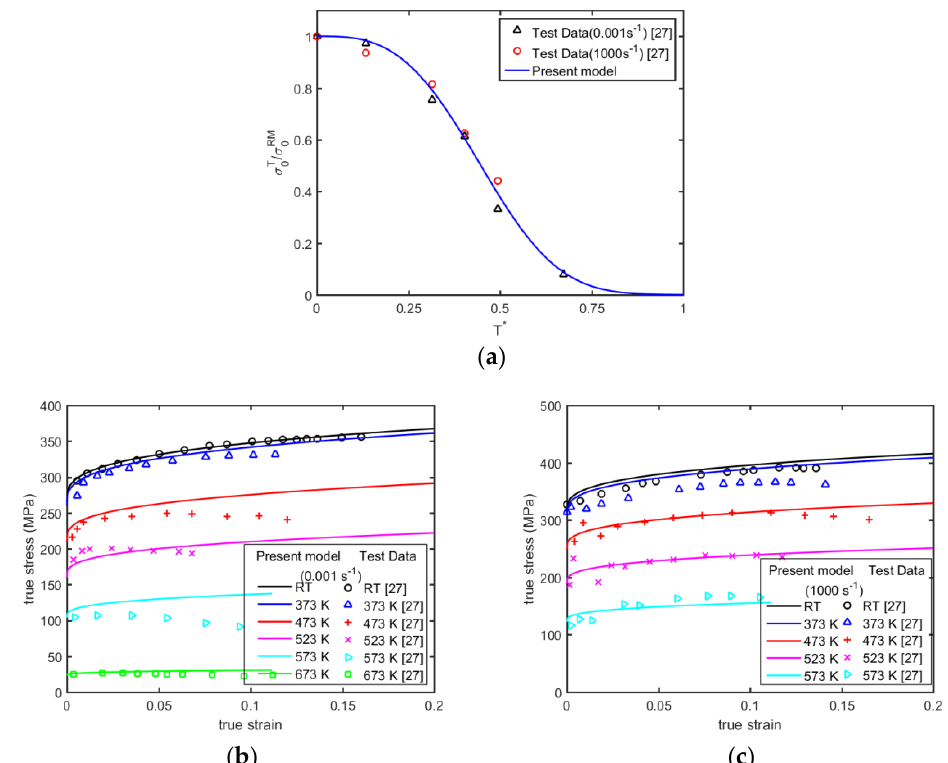
Figure 9. Comparison of the present model predictions with the tensile test data for 6061-T6 aluminum alloy. ( a ) σ 0 T / σ 0 Ta versus T * at a plastic strain of 0.04 under different strain rates; ( b ) true stress-true strain curves at 0.001 s − 1 ; and ( c ) true stress-true strain curves at 1000 s − 1 .